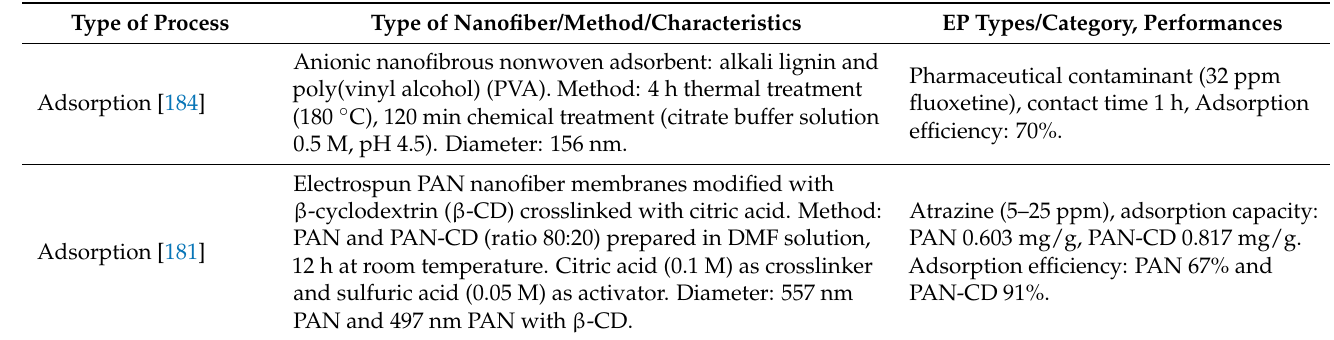
Table 2. Examples of nanofibers with efficiencies in adsorption and advanced decontamination processes for